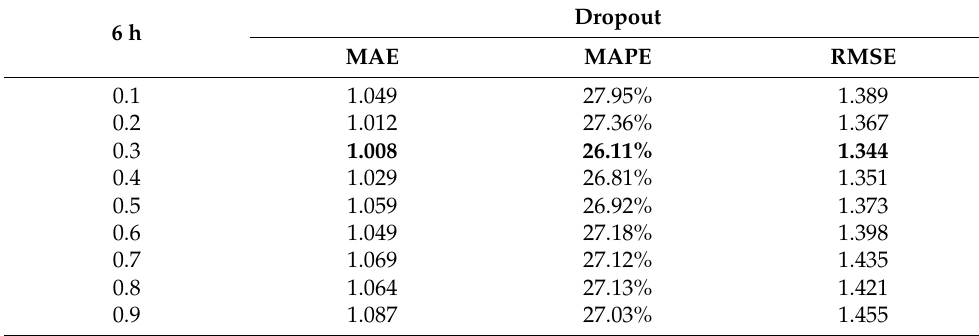
Table A2. It indicates the best performance is achieved when dropout is 0.3. Table A2. The prediction results of parameter study at 40